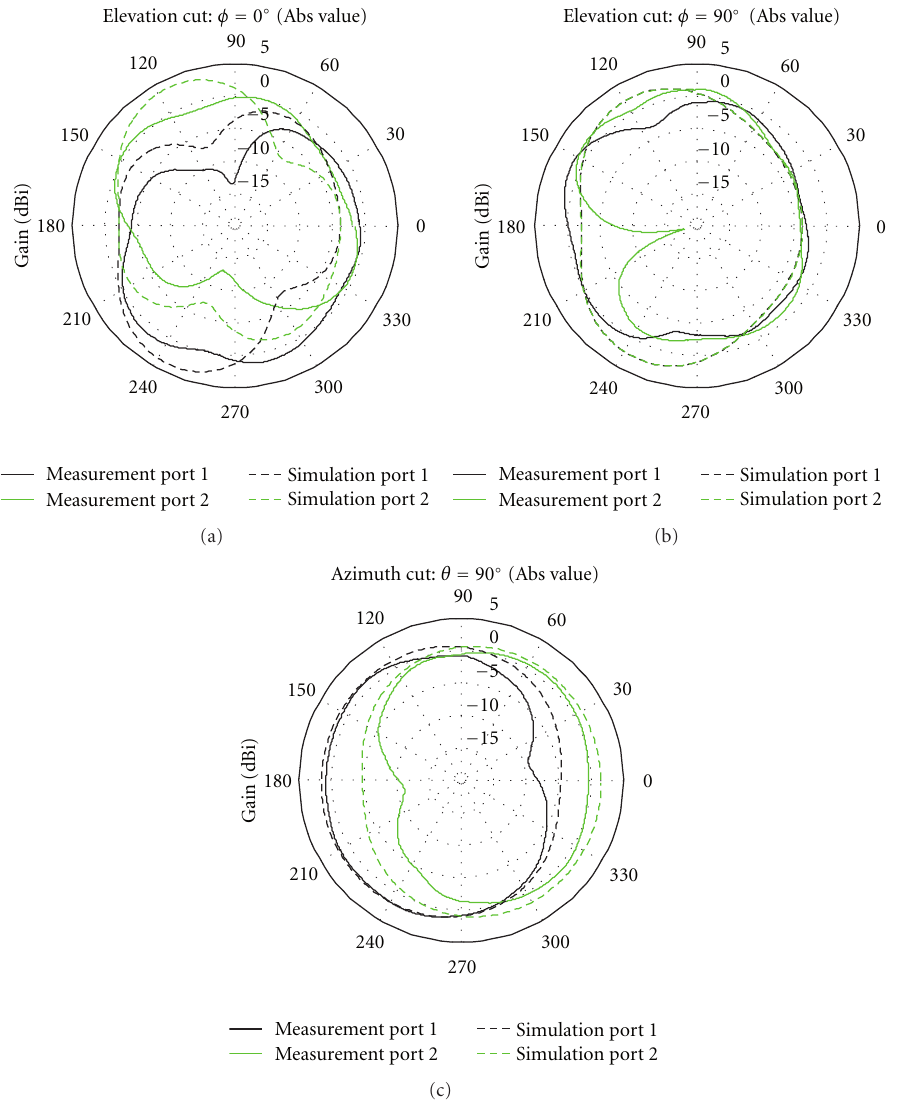
Figure 13: Radiation pattern cuts of the MIMO antenna system #2 (measurements versus